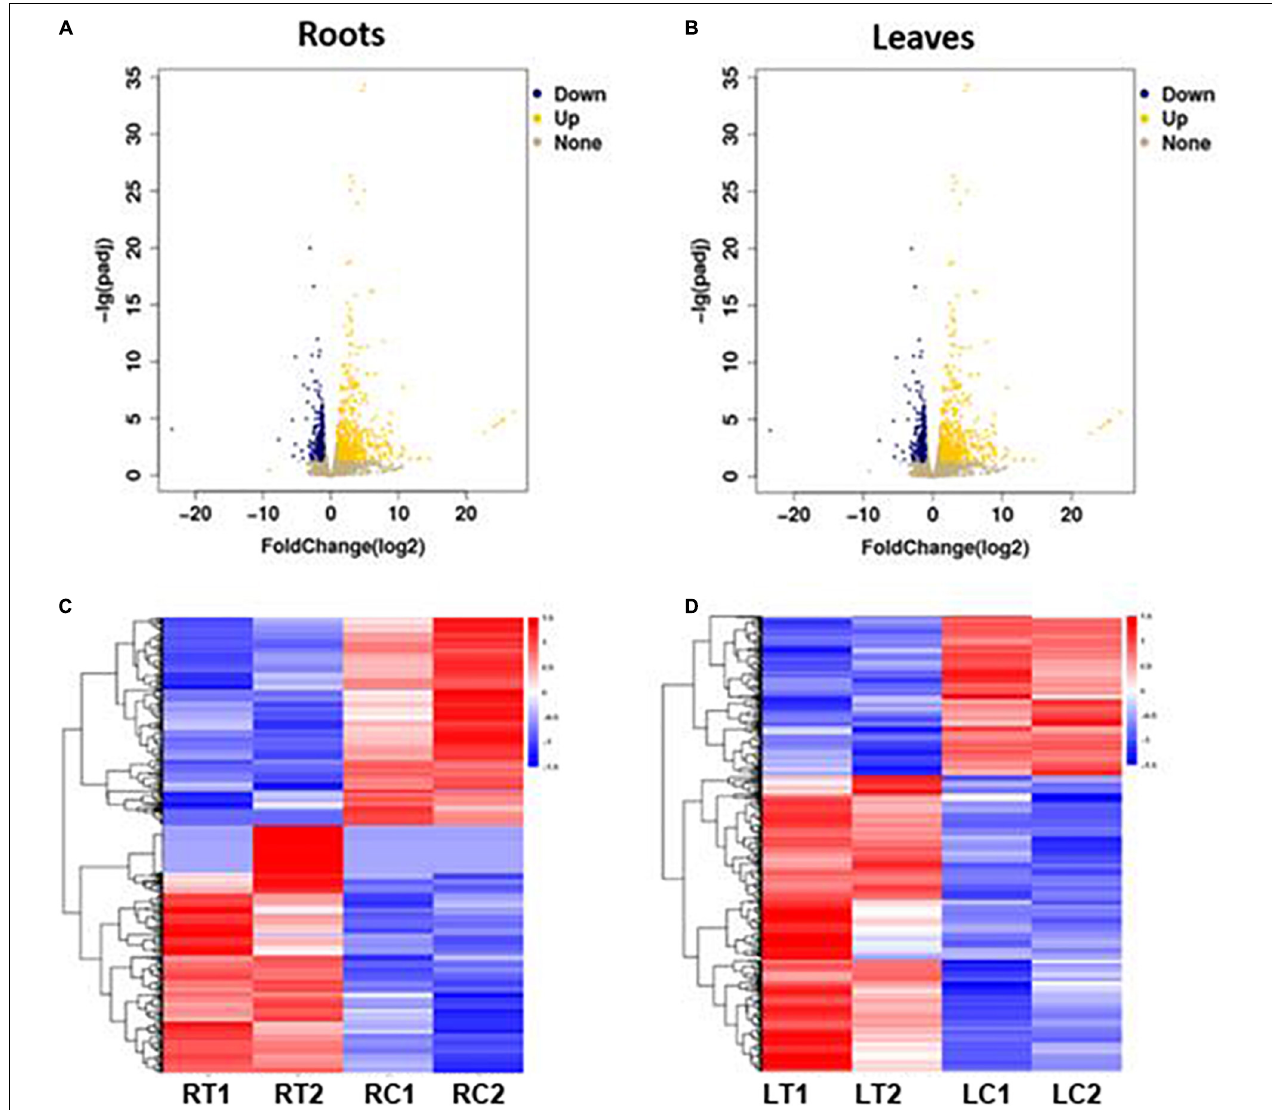
FIGURE 3 | Volcano plots showing the change in expression values among all expressed genes in the roots (A) and leaves (B) of S. argel plants under salt stress as compared to control, and heatmaps showing the expression values of all identified DEGs in the roots (C) and leaves (D) of these plants. RT1: roots treated